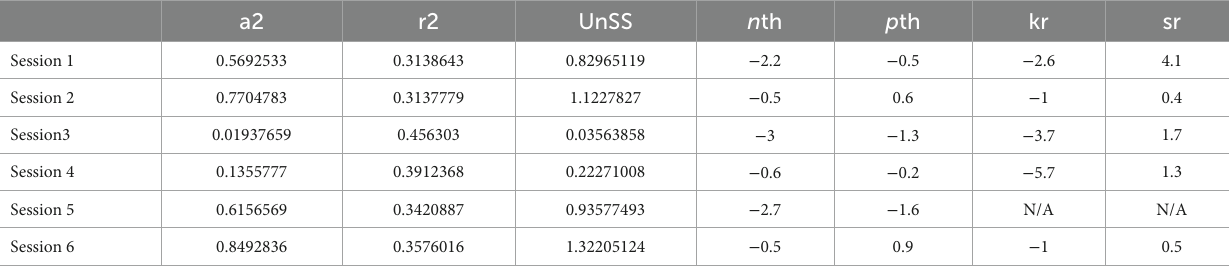
TABLE 3 Dynamical systems model parameters for Jon